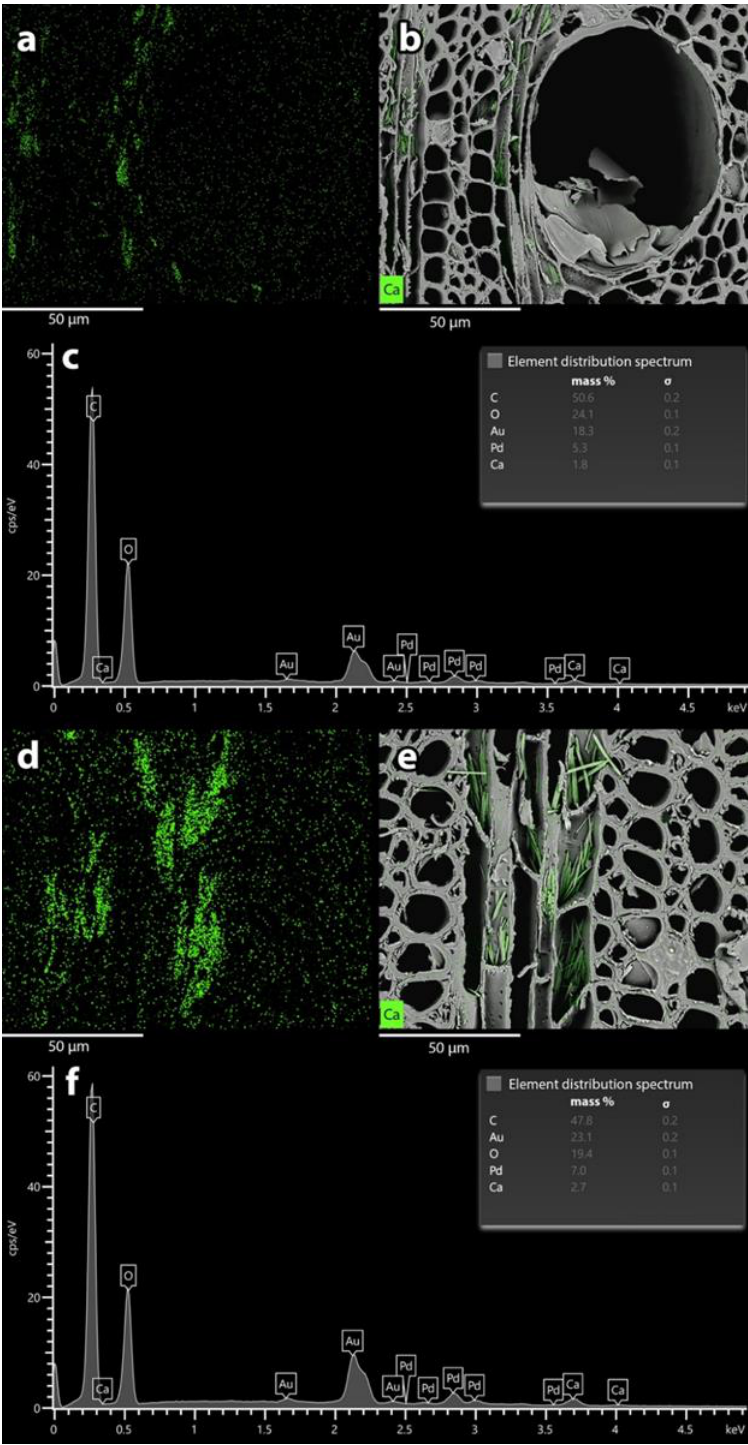
Figure 4. Needle-like crystalline structures found in the ray parenchyma cells of gmelina wood ( a – d ), present in large proportions and identified as calcium oxalate in the EDS spectrum ( e , f ). Solution uptake along the radial direction is more critical in achieving better impreg- nation especially, when impregnating wood with large dimensions. However, as it ap- pears for gmelina wood, it is even much more difficult getting a reasonable depth of